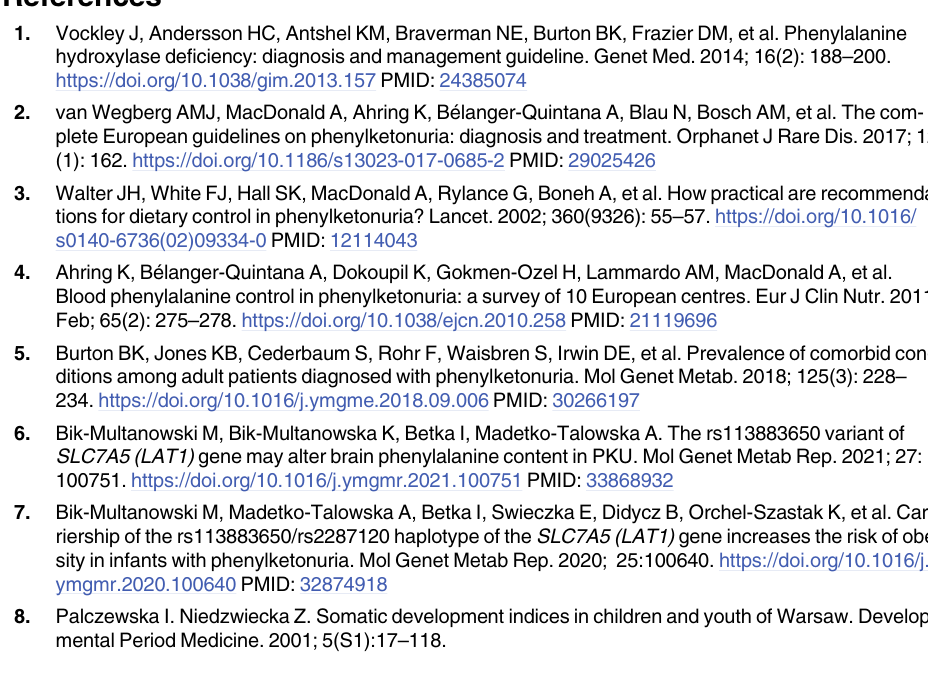
S1 Table. Mutations of the phenylalanine hydroxylase gene ( PAH ) and anthropometric data of the study participants in the context of their sex and their carriership status regard- ing the rs113883650 variant of the LAT1 gene. The body weight and BMI Z-scores are calcu- lated based on the growth charts recommended for the Polish population. Homozygotes for the rs113883650 variant are marked with an asterisk. S2 Table. Blood phenylalanine test results (mmol/l) recorded in participants of the study.